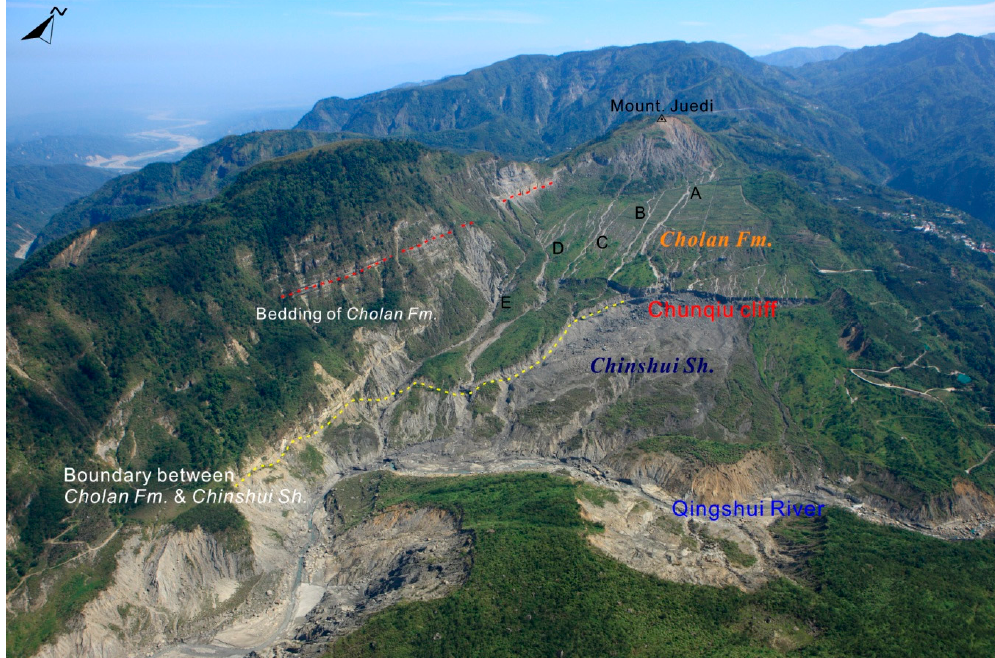
Figure 3. Aerial photograph of the Tsaoling landslide area taken in 2012. The Chunqiu Cliff and the yellow dashed line are the boundary between the Cholan Formation and the Chinshui Shale, while the red dashed line shows the bedding of the Cholan Formation. The Tsaoling landslide area exhibits typical dip-slope topography. The five gullies on the slope surface are represented by A to E in this study. The Qingshui River passes through the toe of the landslide slope.